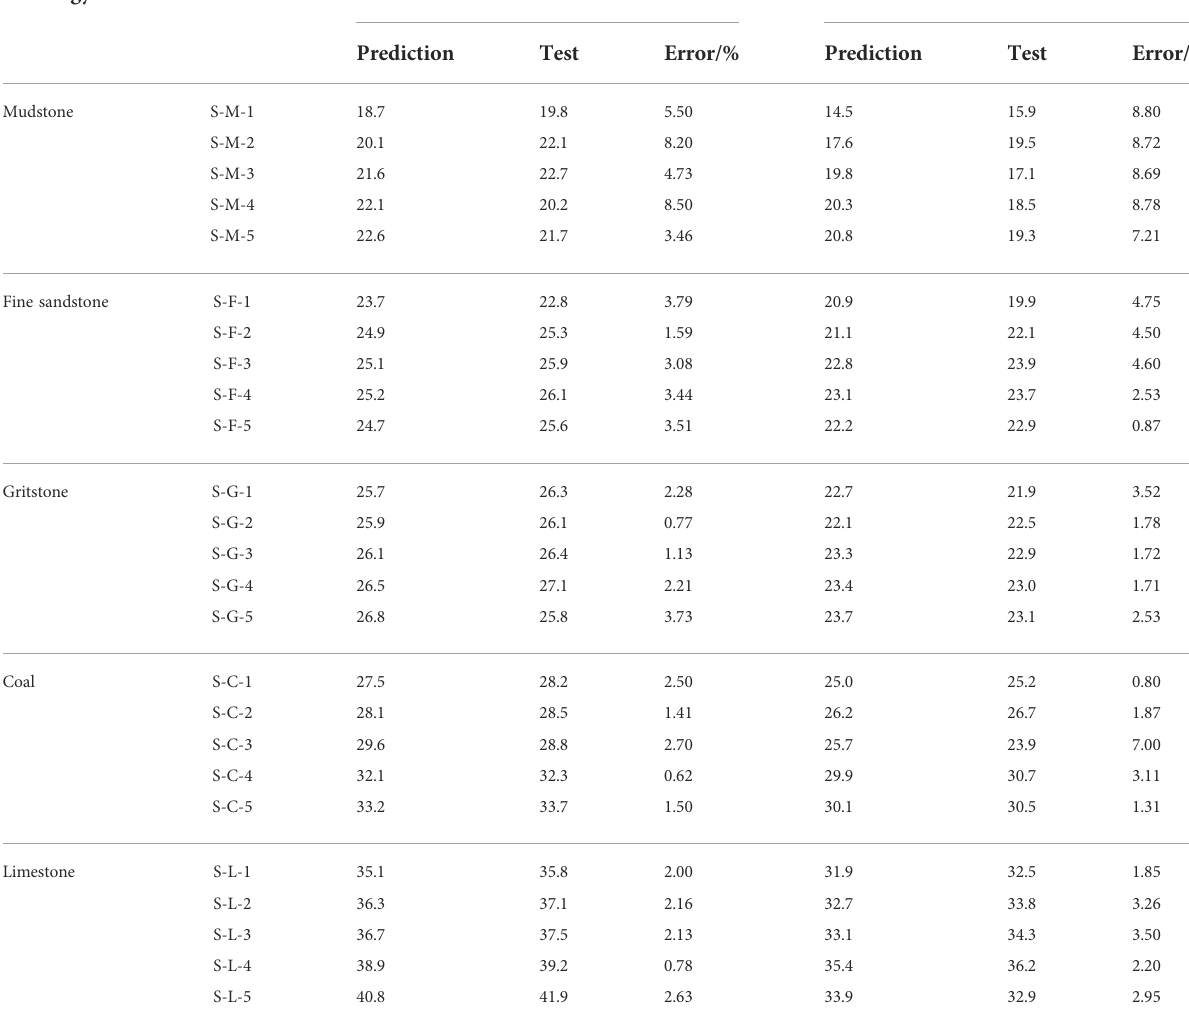
TABLE 3 Contrast between prediction by the new method and test by acoustic